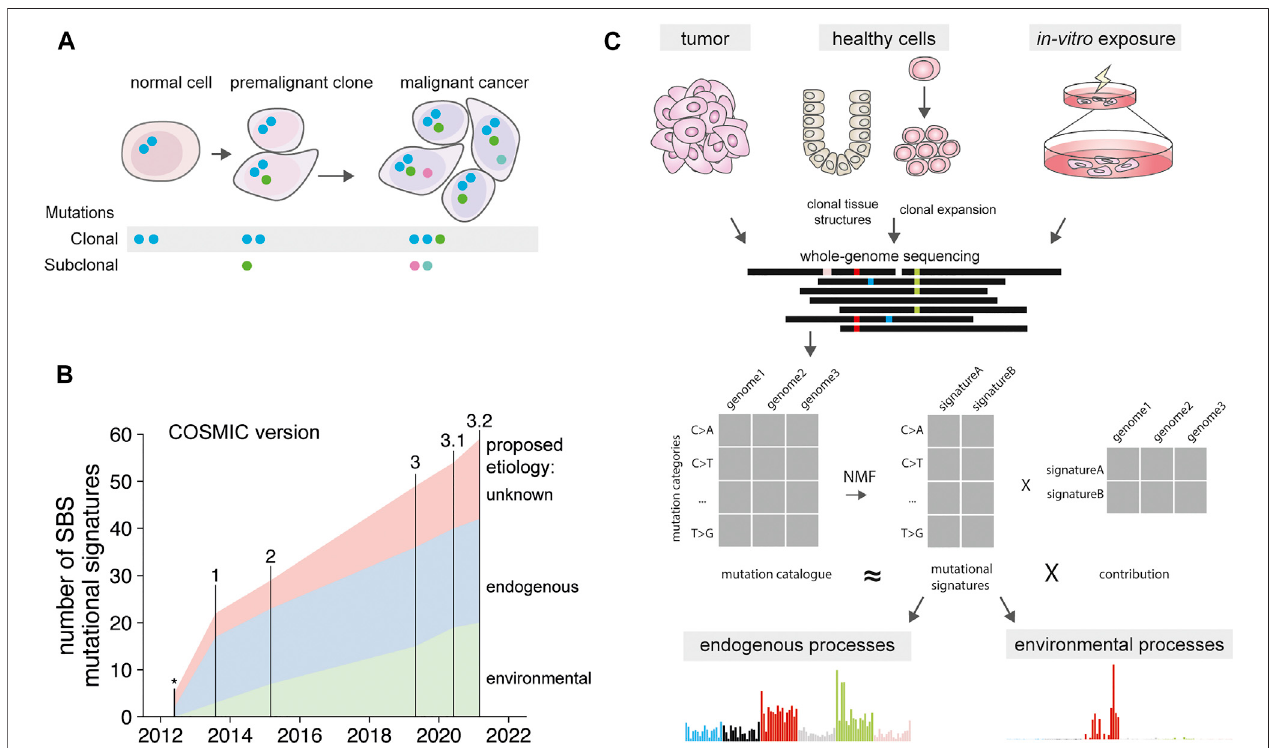
FIGURE 1 | Mutational signatures over time. (A) Presence of clonal mutations in normal cells, premalignant clones and cancer. Blue mutations present in the non- malignant normal cell. These mutations are retained in the premalignant clone and cancer, along with additional mutations acquired during tumorigenesis. Subclonal mutations are independently acquired by each cell, and can become clonal when selective sweeps favor expansion of a subclonal cell population. (B) Number of discovered mutational signatures catalogued in the COSMIC database, version indicated on top. Signature associations determined as in Supplementary Table S1 . *signatures from Nik-Zainal et al., 2012. (C) Depiction of mutational signature extraction using tumor cells, normal cells and in vitro exposed cells as input source. Signatures can be extracted from the mutation catalogues using non-negative matrix factorization. This results in both signatures, and their relative contribution in each tumor